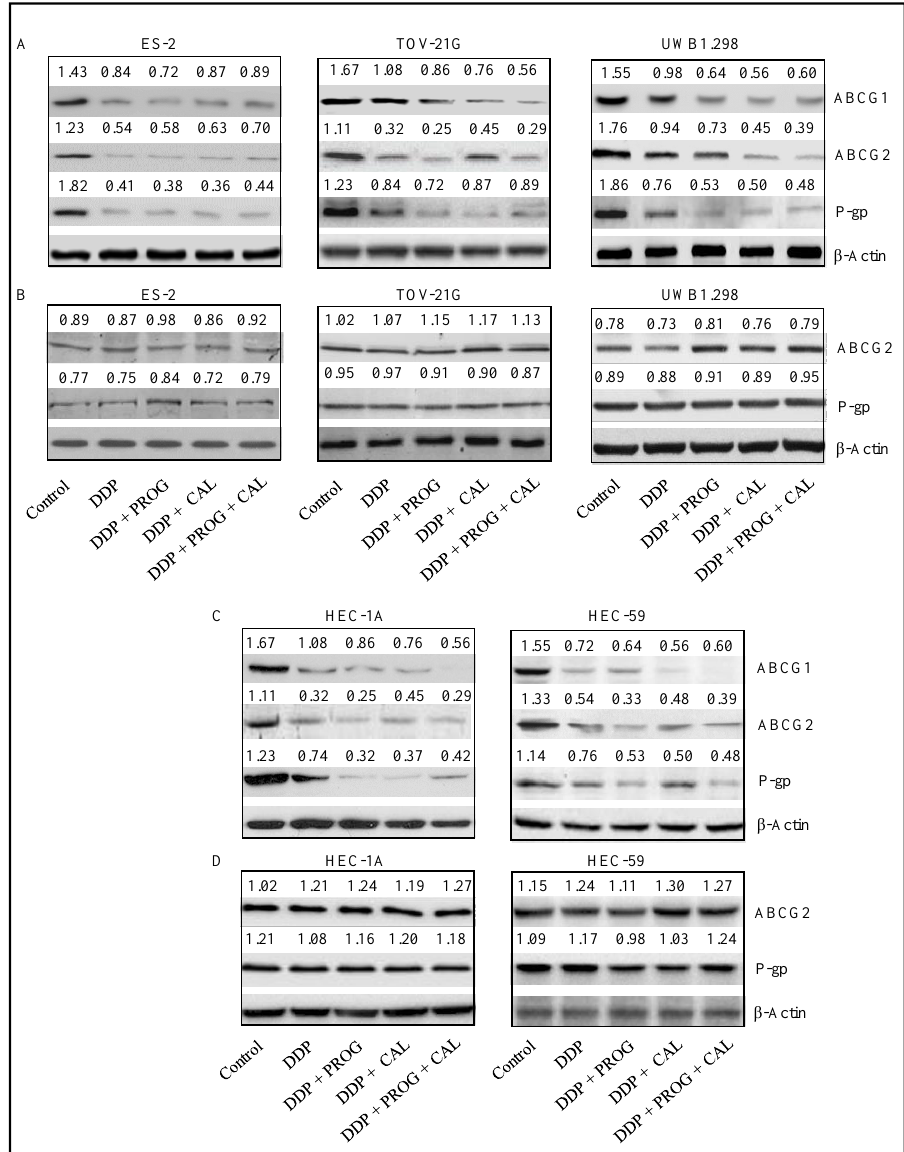
Figure 5. Progesterone-calcitriol combination enhanced the inhibitory effect of DDP by attenuating ABCG efflux proteins in cancer cells. The cancer cells were treated with DDP (6 µM), progesterone (20 µM), calcitriol (30 nM) or progesterone-calcitriol combination in the presence ( B , D ) or absence ( A , C ) of ABC transporter inhibitor (Elacridar hydrochloride, 0.25 µM) for 72 h and expression changes of ABCG1, ABCG2, and MDR- 1 proteins were assessed. β -actin was used as a loading control. The values above the bands represent the relative density of the bands normalized to β -actin.